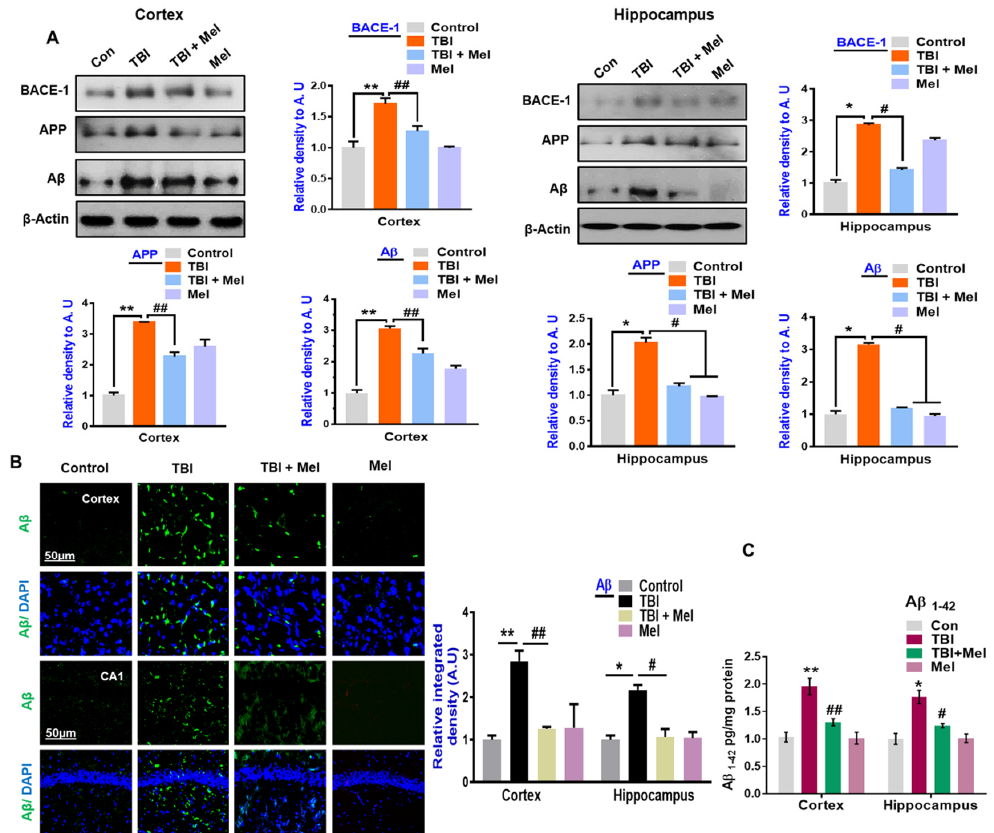
Figure 6. Melatonin inhibits Alzheimer’s disease (AD) ‐ like pathological changes in the traumatic brain injury (TBI) ‐ induced mouse brain. (A) Showing the Western blot results of β‐ APP ‐ cleaving enzyme ‐ 1 (BACE ‐ 1), amyloid precursor protein (APP), and A β in the cortex and hippocampus of the experimental groups, with respective bar graphs. Magnification, 10×. n = 10 mice per group. Beta ‐ actin was used as a loading control. (B) Confocal microscopic results of A β expressions in the different experimental groups, with the respective bar graph. Magnification, 10×. n = 5 mice per group. The images were quantified using ImageJ software. (C) Representative histogram showing the level of A β 1 ‐ 42 in the ipsilateral cortex and hippocampus among the treated mice groups. The differences have been shown in the graphs. The values are expressed as mean ± SEM. One ‐ way ANOVA followed by post ‐ hoc analysis. * p < 0.05 and ** p < 0.01 represent difference between control and repetitive mild traumatic brain injury (rmTBI), and # p < 0.05 and ## p < 0.01 represent difference between rmTBI plus melatonin (Mel) ‐ treated group .